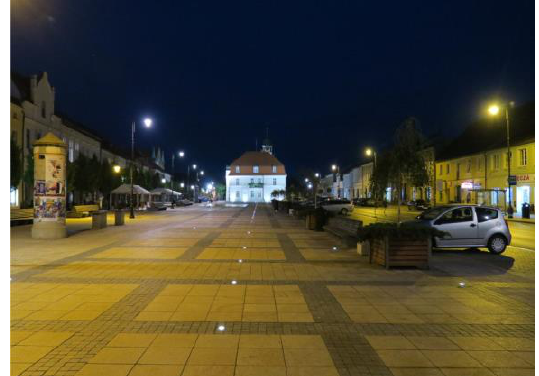
Fig. 3. Illumination and road illumination of the historical part of the city of Kórnik